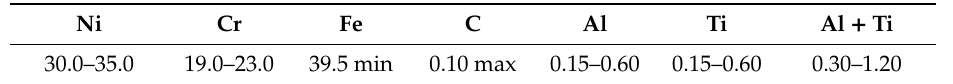
Table 1. Chemical composition of Inconel-800 alloy.